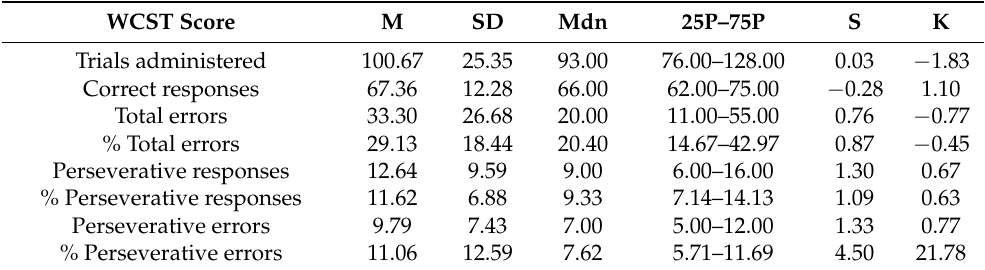
Table 2. Postpartum women’s performance in the Wisconsin Card Sorting Test ( n =